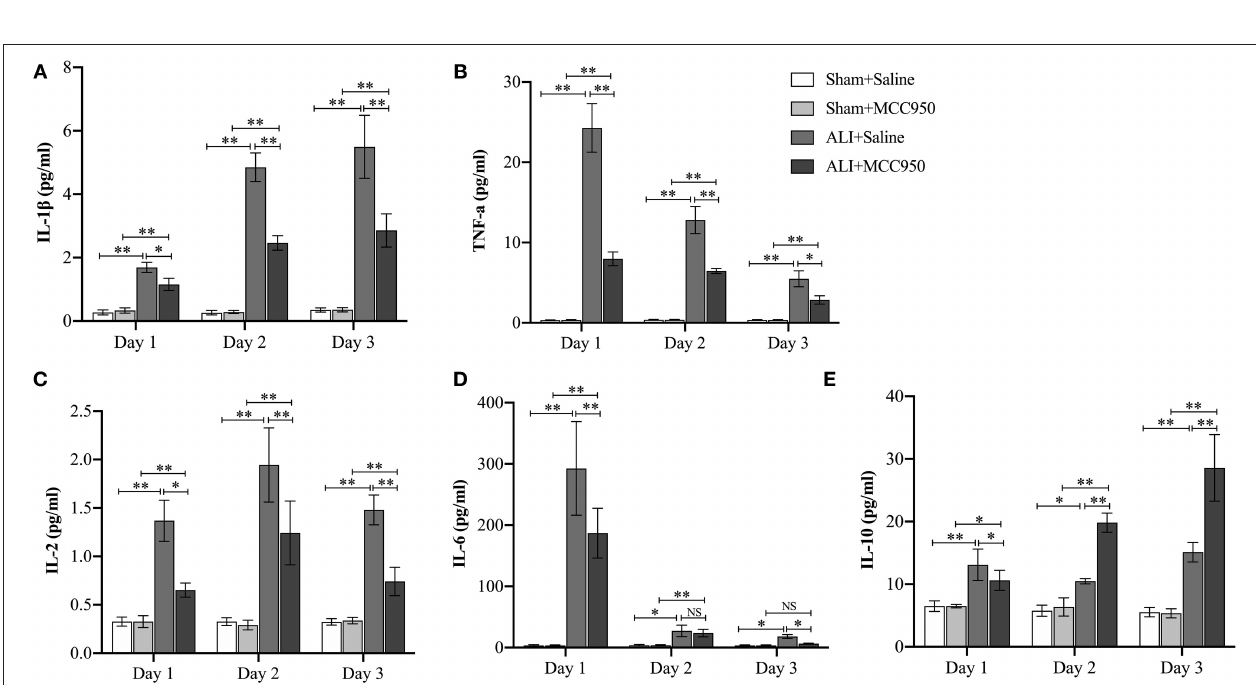
FIGURE 5 | MCC950 treatment rescues cytokines dysfunction in acute liver injury. Levels of IL-1 β (A) , TNF- α (B) , IL-2 (C) , IL-6 (D) , and IL-10 (E) in serum from mice in different groups. Data are presented as mean ± SEM. NS: No significance * p < 0.05, ** p < 0.01. Intergroup differences are determined by the Student’s t -test.